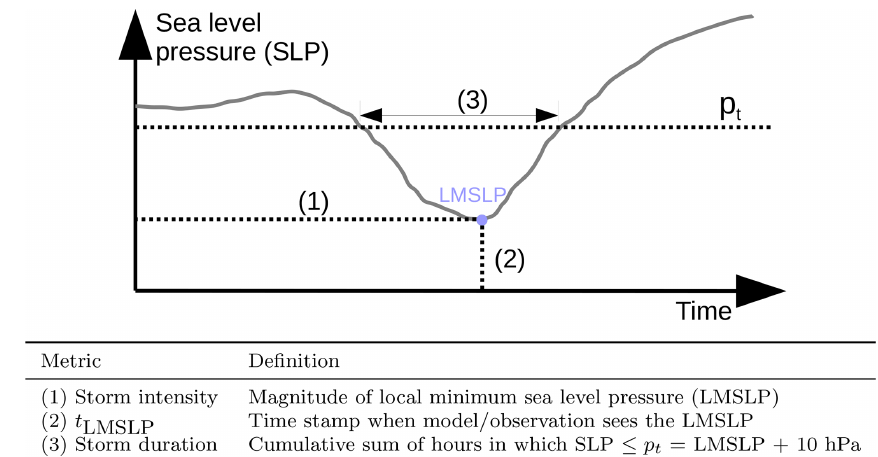
Figure 1. Definition of the three evaluation metrics storm intensity (1), time of local minimum sea level pressure t LMSLP (2) and storm